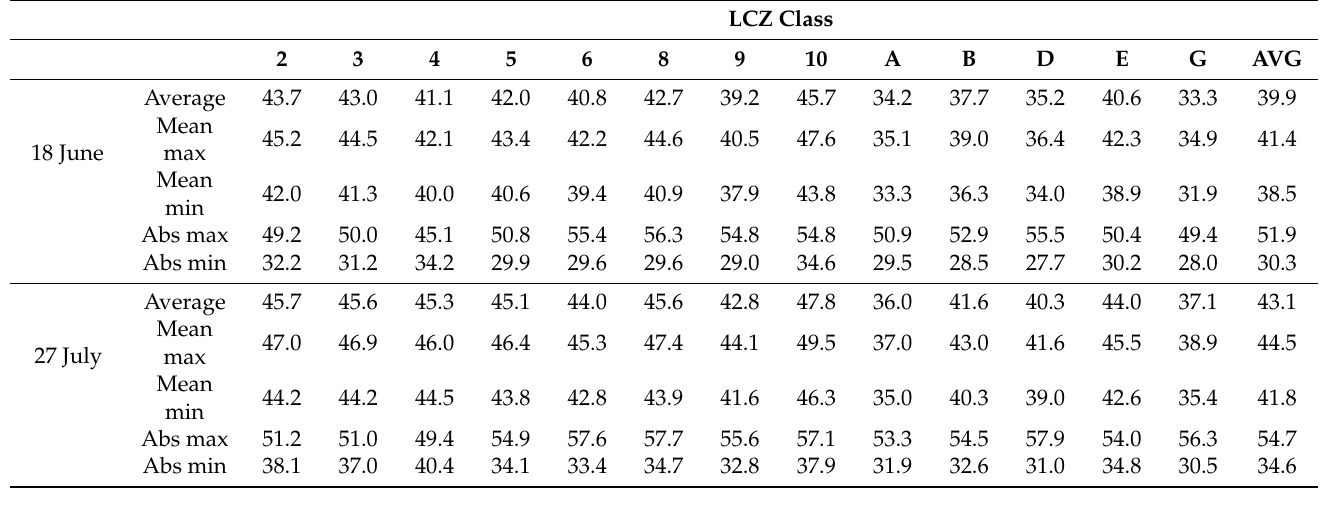
Table 4. LST ( ◦ C) in LCZ classes in study area.